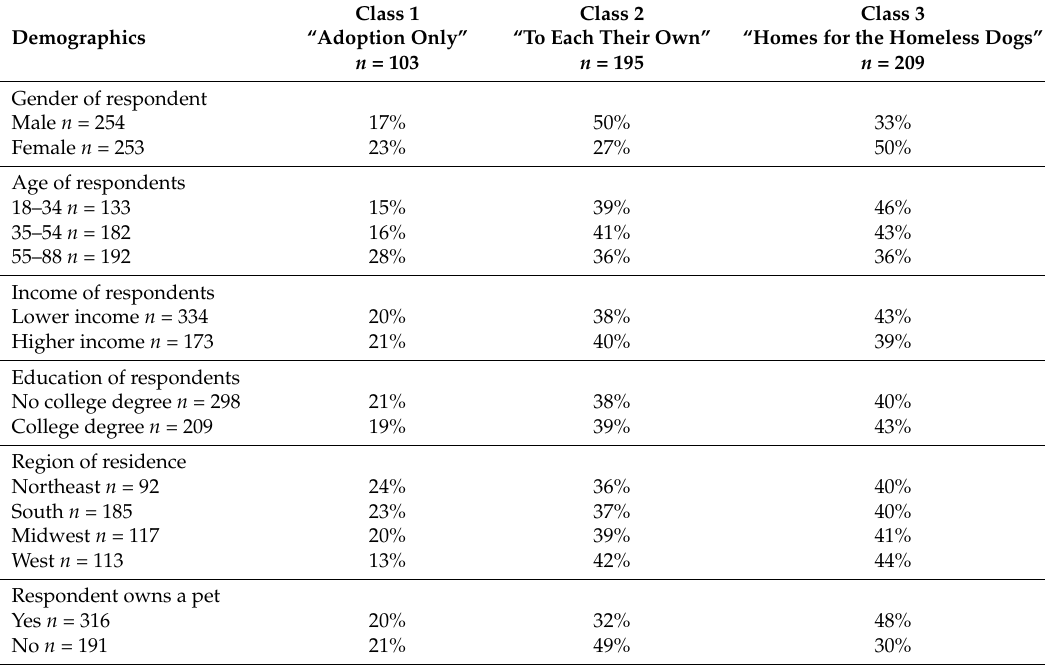
Table 7. Percentage of demographic categories probabilistically assigned to each LCM